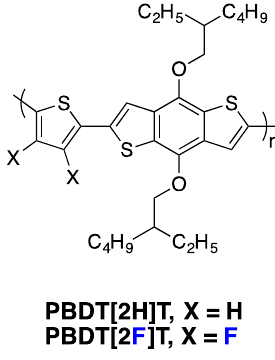
Figure 20. Chemical structures of the investigated PBDT[2X]T polymers [31].